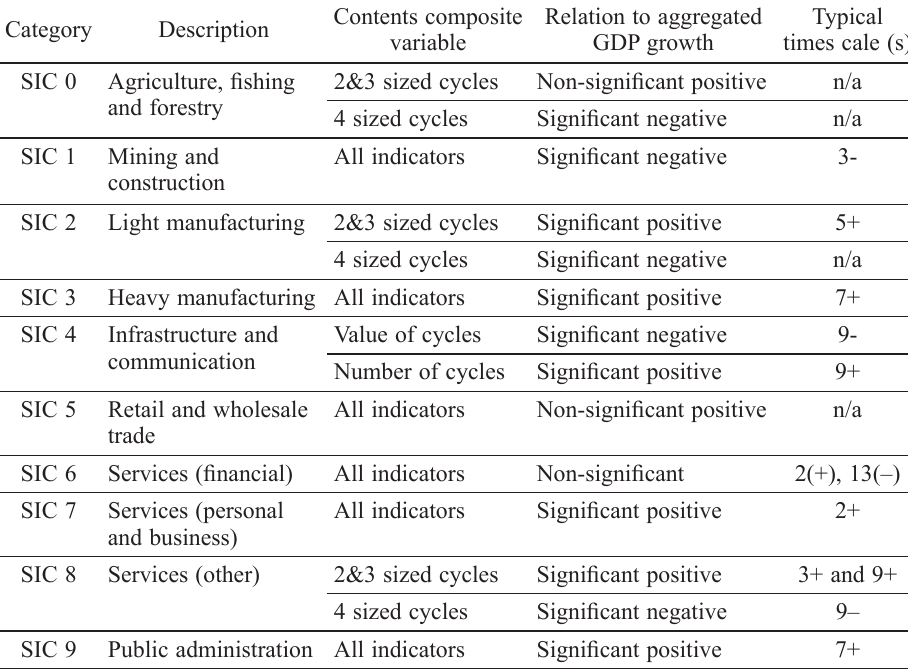
Table 4. Overview of regression results per goods